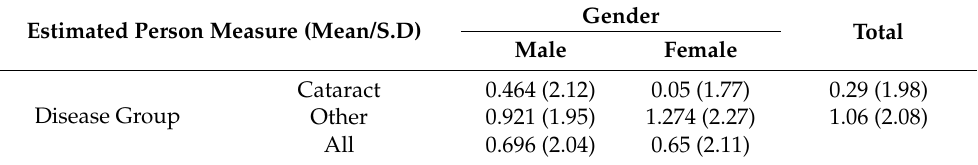
Table 5. Results from the application of the VF-8G scale in the research sample. Estimated Person Measure